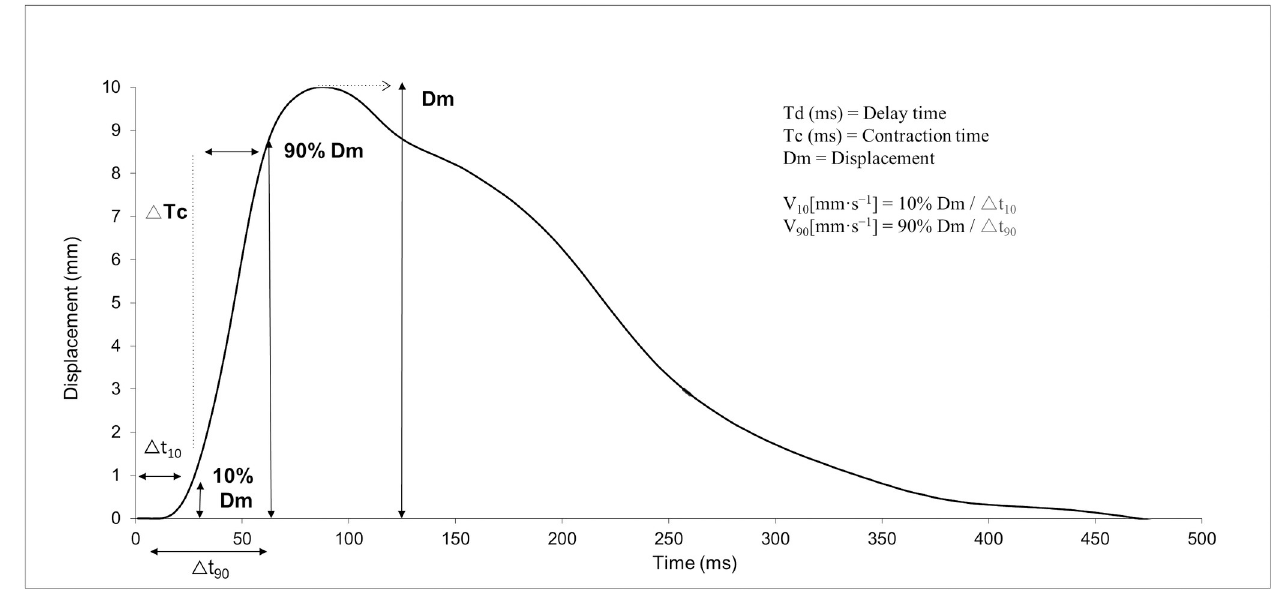
Fig 3. TMG Parameters. Td: delay time; Tc: contraction time; Dm: maximal radial displacement.